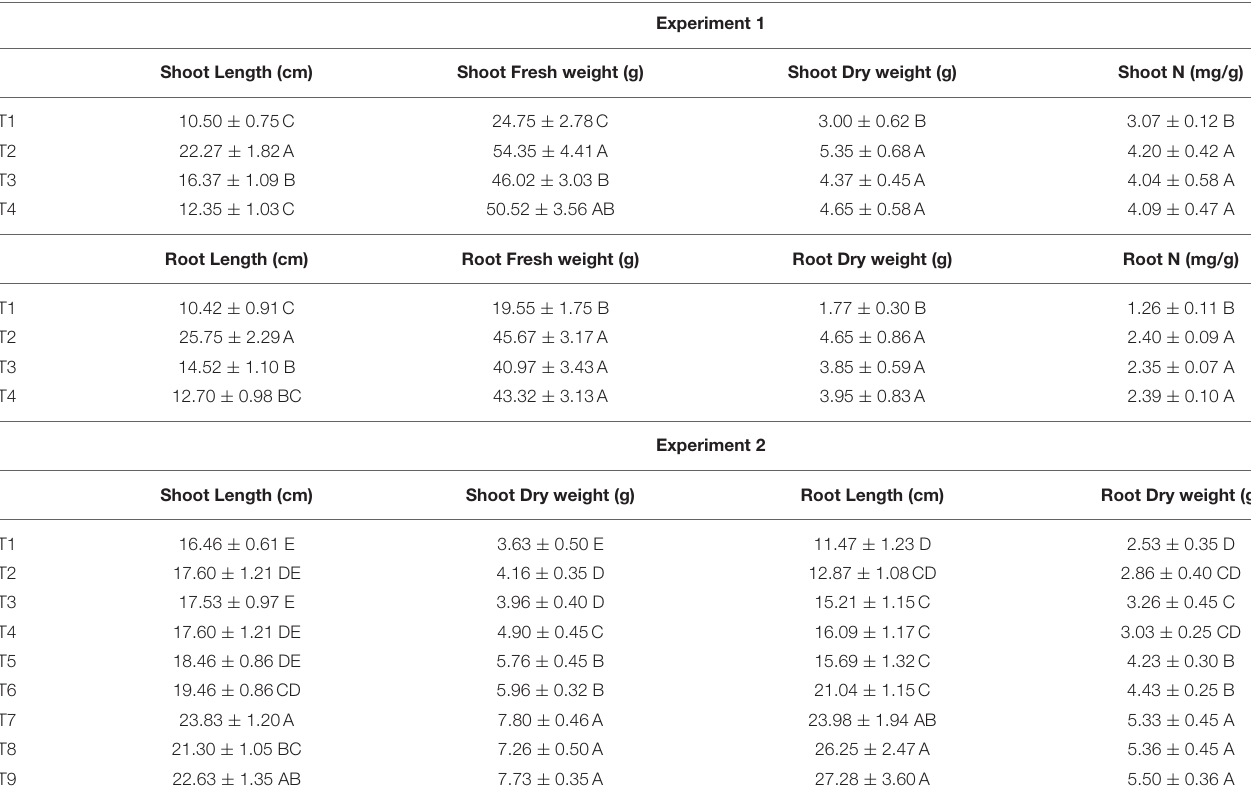
TABLE 3 | Inoculation response of Azospirillum spp. strains TN03 and TN09 of 1st pot experiment and 2nd pot experiment on root and shoot.